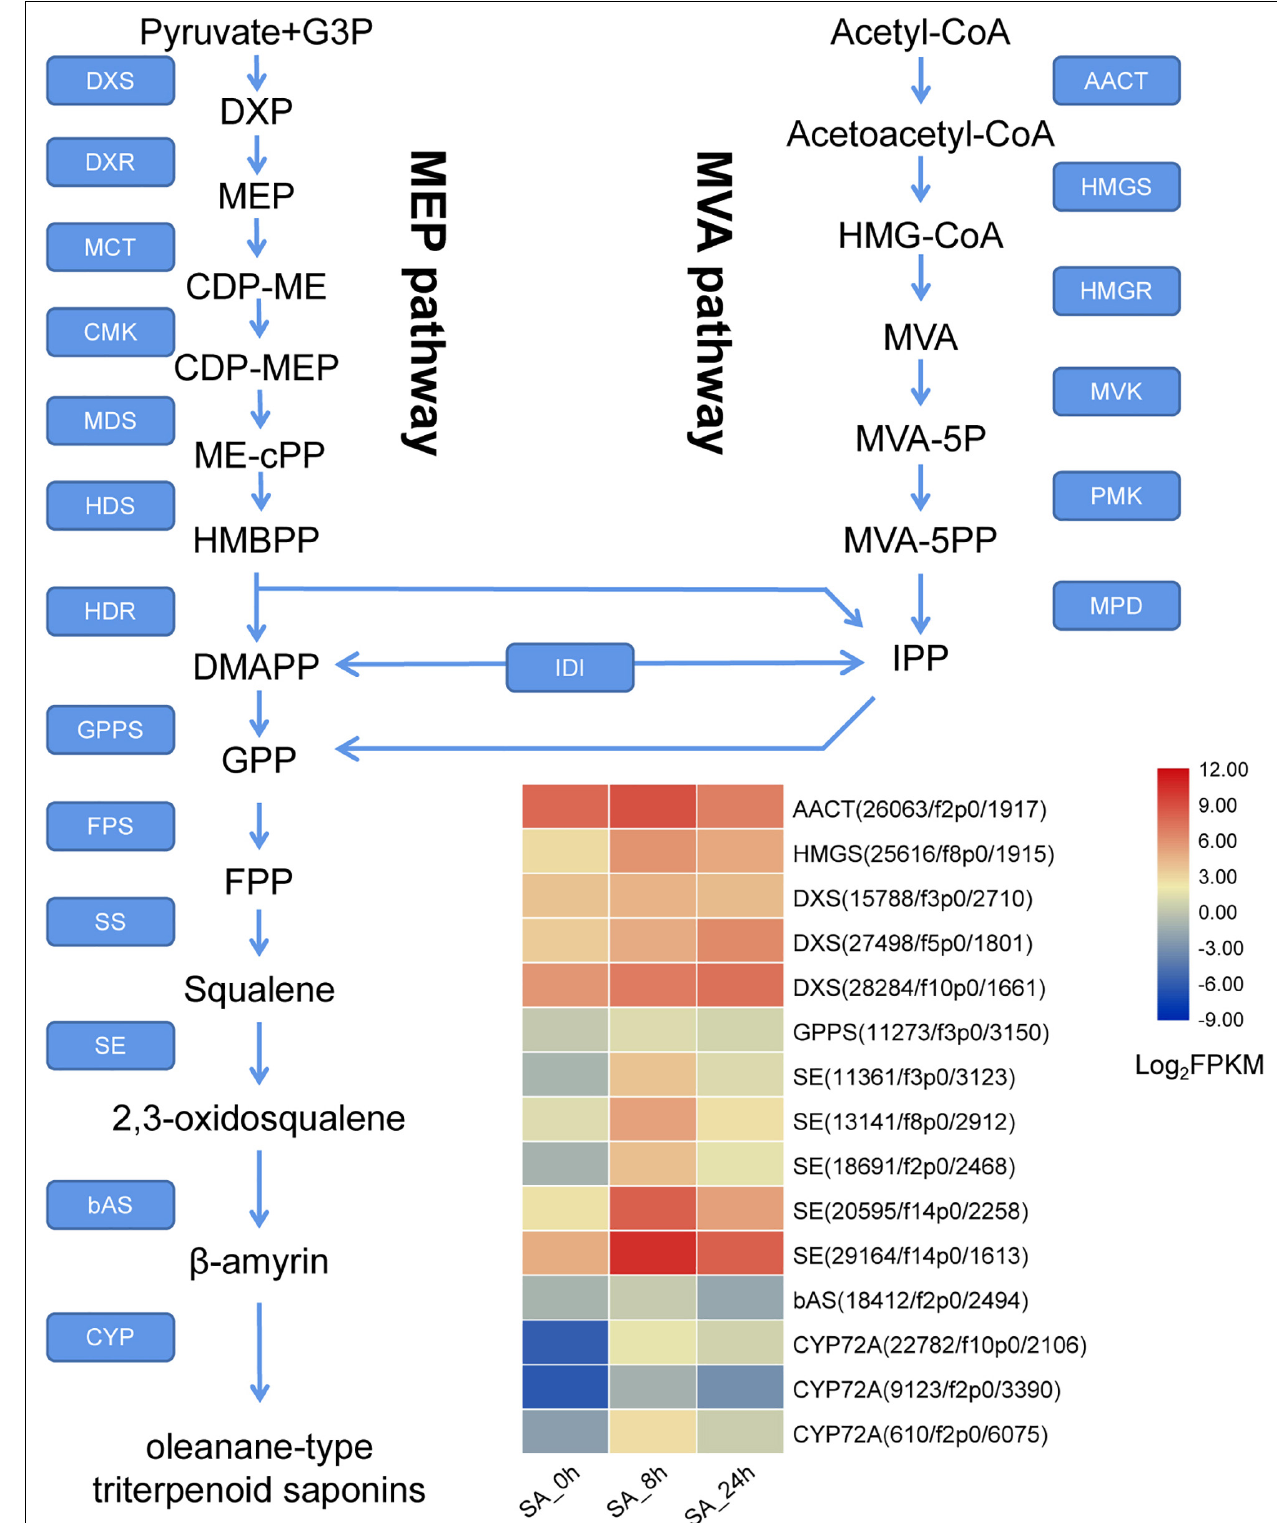
FIGURE 7 | The putative expression profiles of SA-elicited saponin biosynthesis in P. tunicoides hairy root cultures. The heat graph shows the up-regulated unigenes encoding enzymes involved in saponin biosynthesis under SA treatments. The FPKM values of unigenes were log2 transformed.